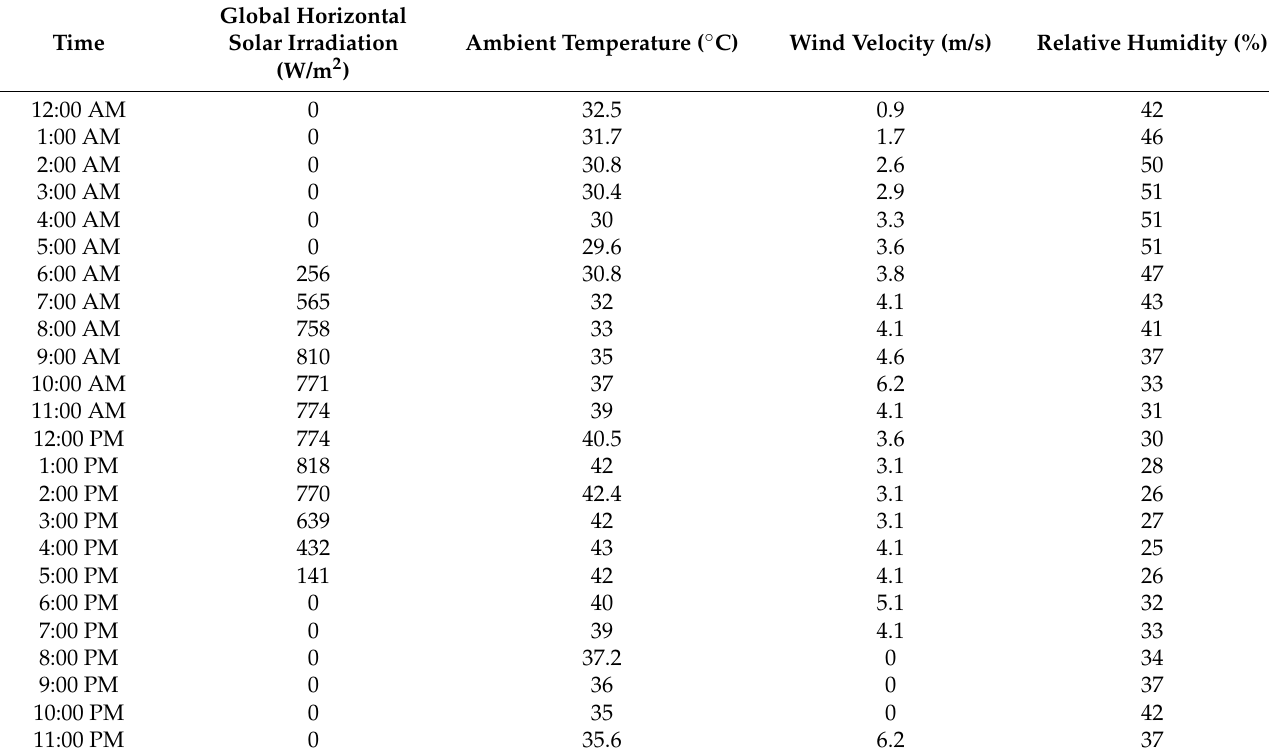
Table 3. The 24 h weather data on 30 July 2014 in the city of Aqaba,